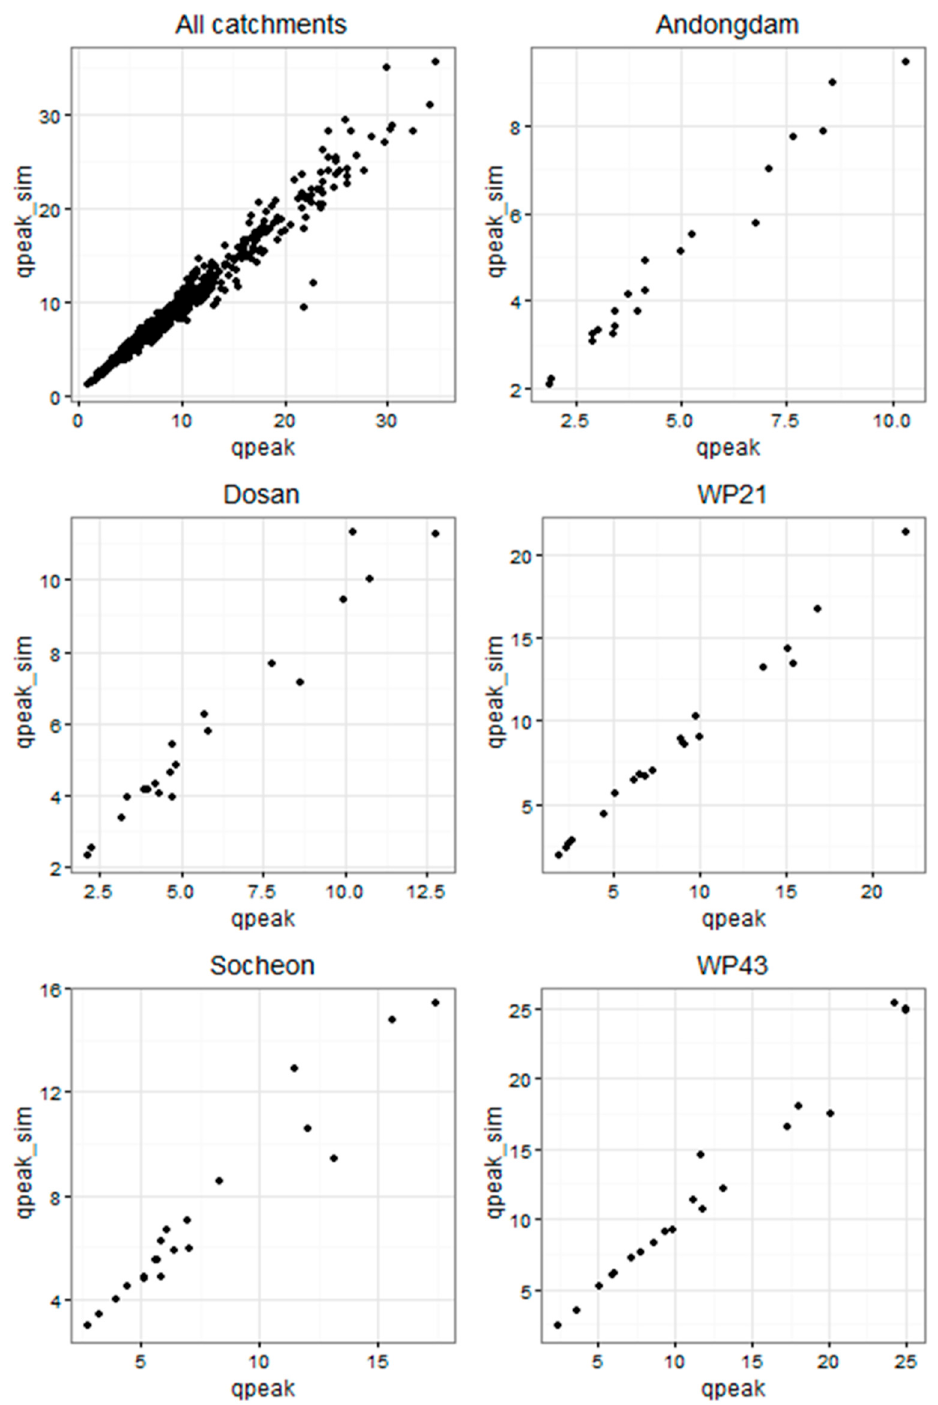
Figure 8. Comparison of the peak flow (qpeak) and the simulated peak flow (qpeak_sim) based on the rational method and simulated C ( C sim ).